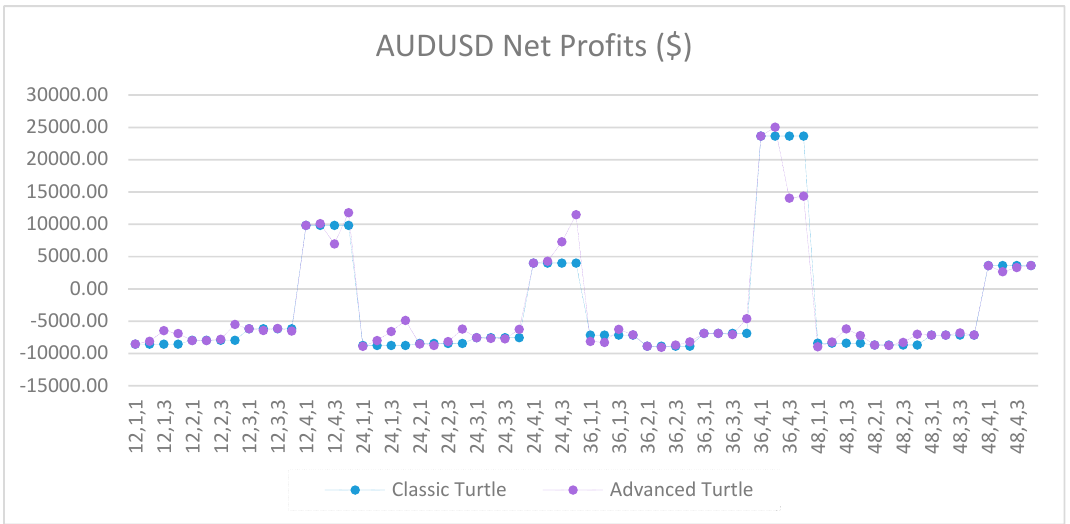
Figure A33. Net profits of AUDUSD between the classic and the advanced Turtle systems for every combination of N, X, Y for the slow parameters (80, 160).